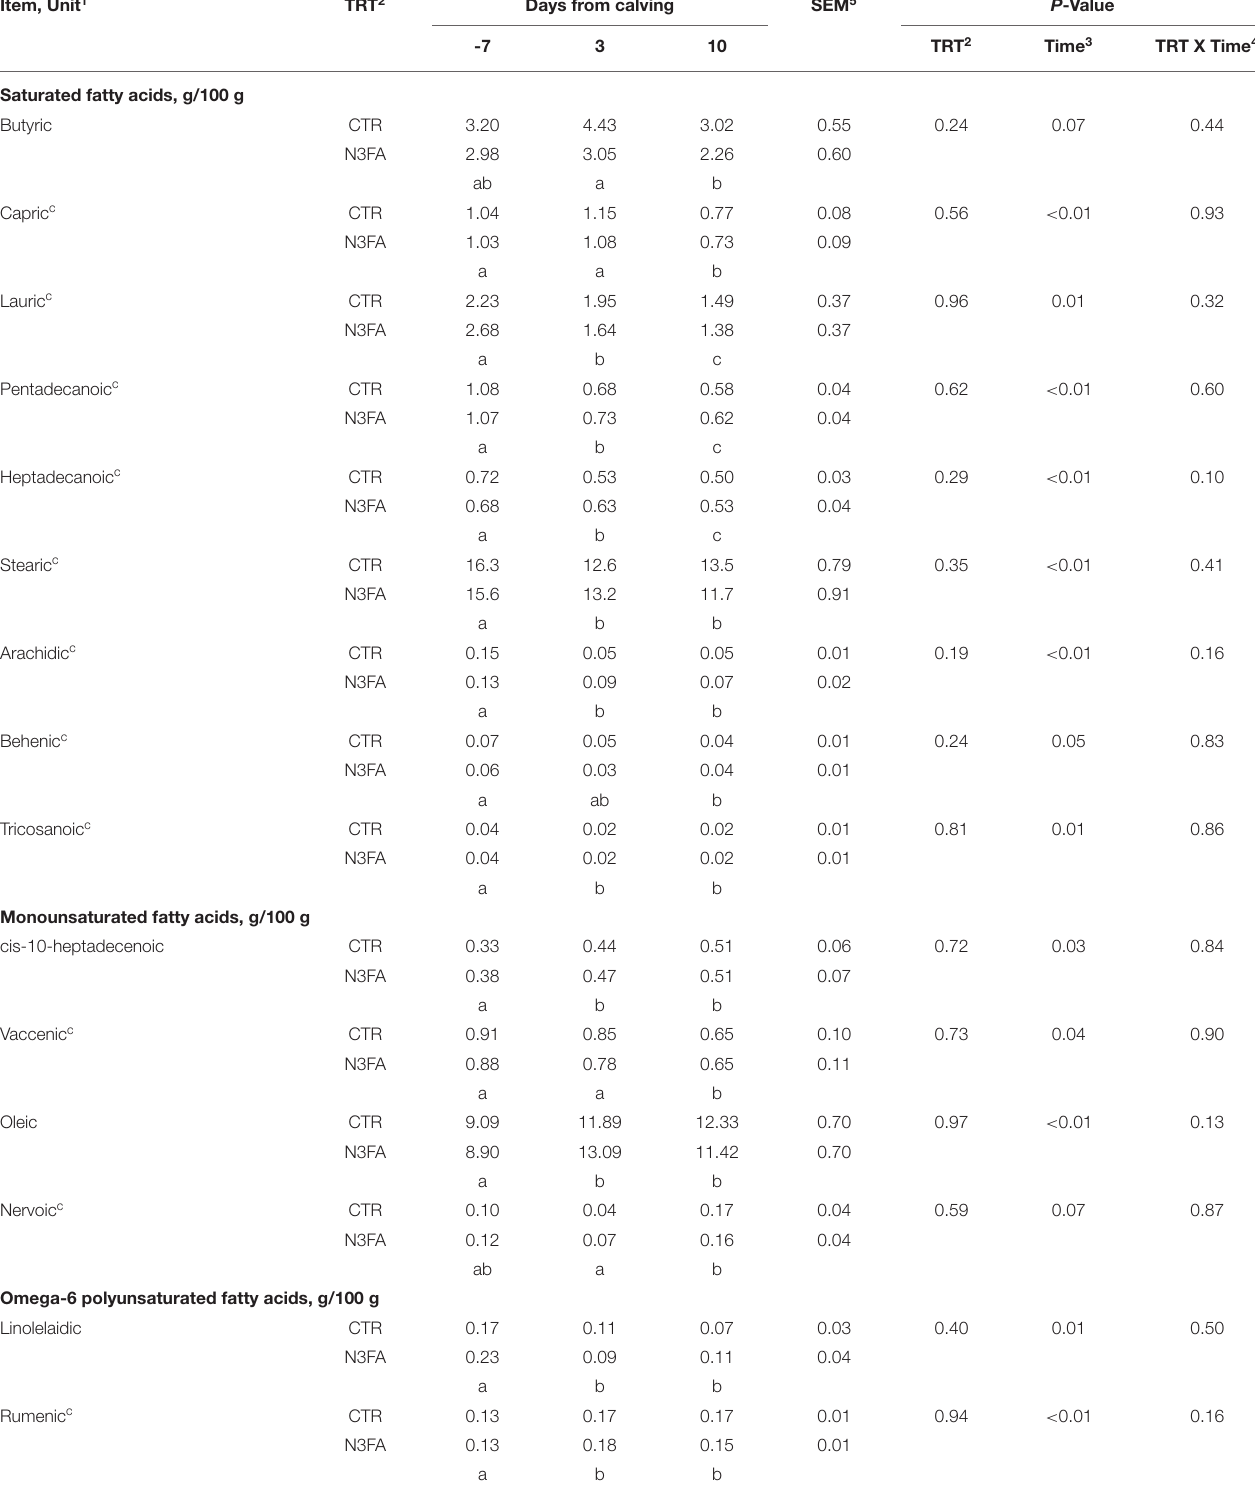
TABLE 4 | Trends of plasma fatty acids profile in dairy cows infused with 150ml of sterile saline or 150ml of a 10% solution containing purified fish oil rich in long-chained omega-3 fatty acids at 12, 24, and 48h after calving. Item, Unit 1